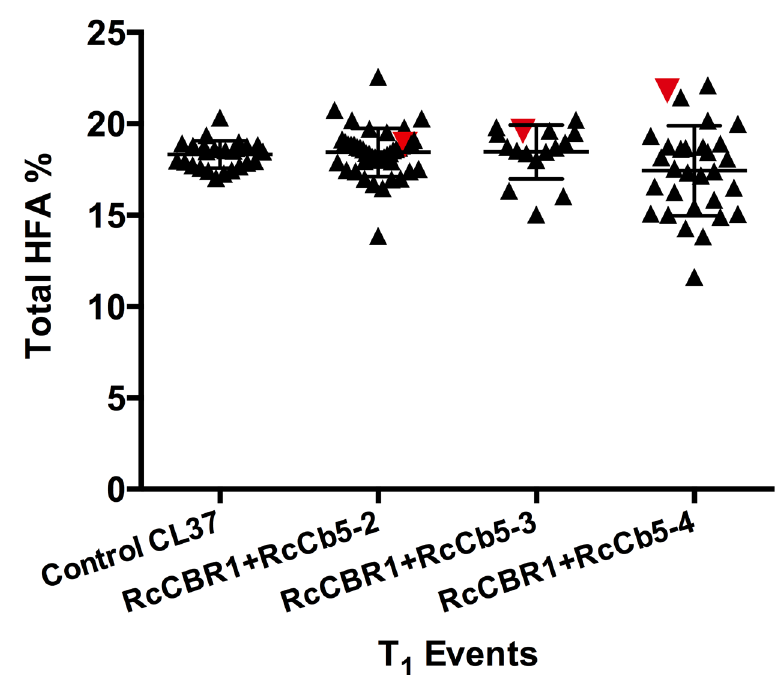
Figure 5. Total HFA accumulation in seed of individual RcCBR1+RcCb5 CL37 primary transformants. Total HFA (18:1-OH+18:2-OH) contents of mature T seeds from individual transformants expressing RcCBR1+RcCb5-2, RcCBR1+RcCb5-3 or RcCBR1+RcCb5-4 in the 2 CL37 line. Results are compared with untransformed CL37 controls grown alongside T plants. Red inverse triangles indicate events that were 1 further analyzed. Error bars represent standard deviation; n=25 for control CL37, n=45 for RcCBR1+RcCb5-2, n=16 for RcCBR1+RcCb5-3, and n=30 for RcCBR1+RcCb5-4.